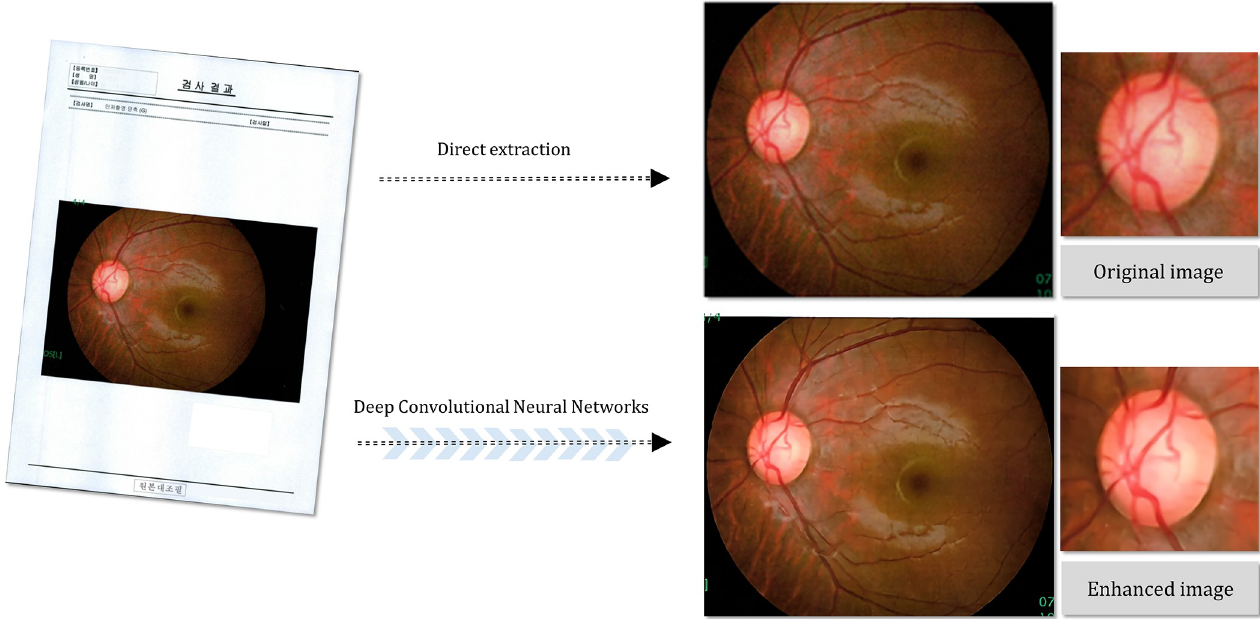
Fig 8. Example of fundus photography transferred from another institution as printed document. (A) Original document, (B) directly extracted fundus image, (C) magnified image of optic disc in original fundus photography, (D) deep-learning-based enhanced fundus photography, (E) magnified image of optic disc in enhanced fundus photography. The enhanced fundus photography improved the structural details of the optic disc, neuroretinal rim margin and vessel contours.